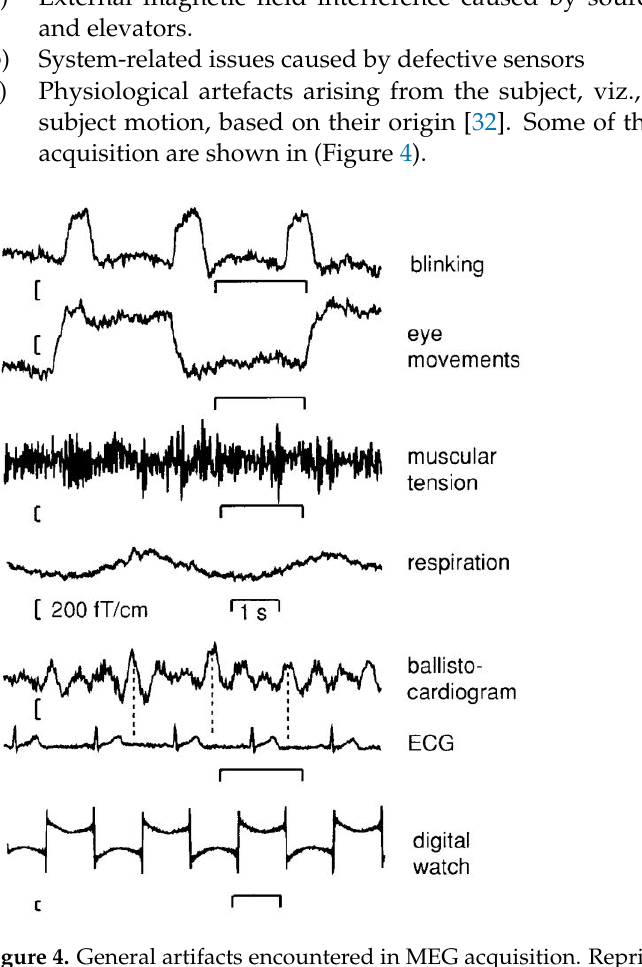
Figure 4. General artifacts encountered in MEG acquisition. Reprinted from [33]. (Copyright 2017 Oxford University Press) Image reproduced as per terms of CC BY 4.0